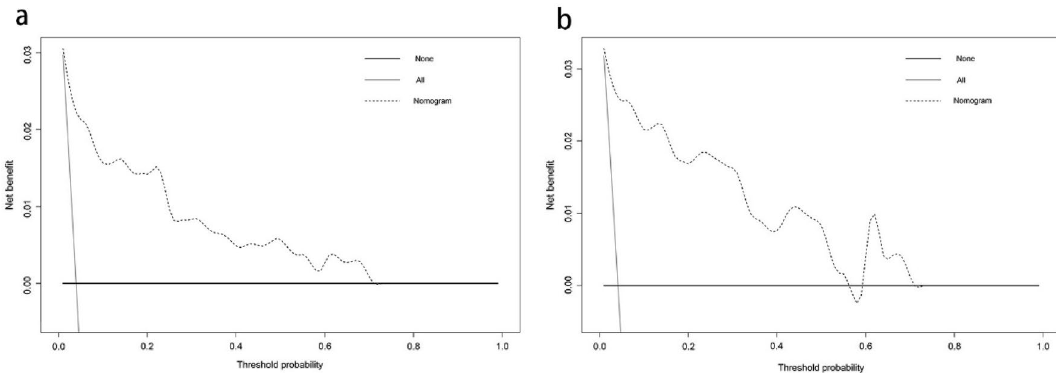
Figure 5. Comparison of the decision curve analyses (DCA) of the nomogram in the training cohort ( a ) and the validation cohort ( b ). The X-axis represents the threshold probability and the Y-axis represents the net benefit. The dotted line represents the nomogram, The black line assumed that no patient has DVT before surgery, while the gray line represented the assumption that all patients have preoperative DVT. The range of threshold probabilities representing positive net benefit is obtained according to the corresponding points of the intersection of the dotted line with the black line and grey line on the